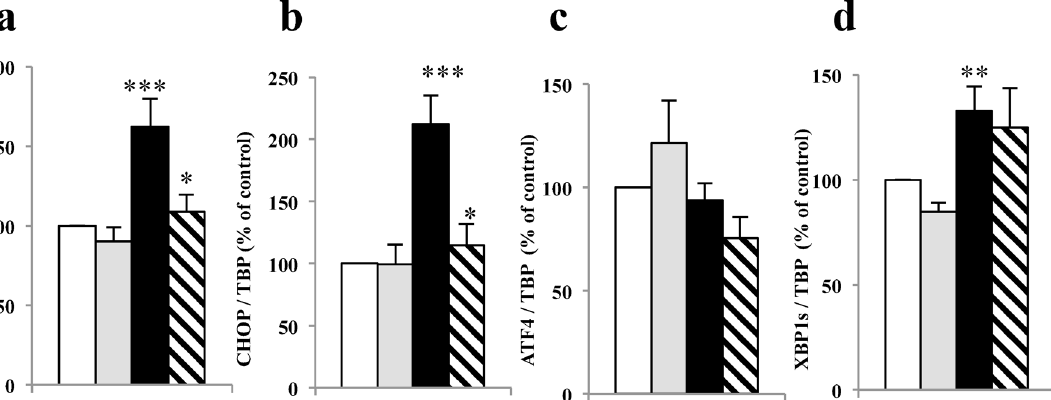
Fig 3. Translocon inhibition partially modulates palmitate-induced ER stress. ER stress mRNA expression markers were measured after 48h BSA (white bar) + anisomycin (grey bars) or palmitate (black bar) + anisomycin (hatched bars) treatment in 5 different human islet preparations. *** p < 0.001; ** p < 0.01; * p < 0.05.